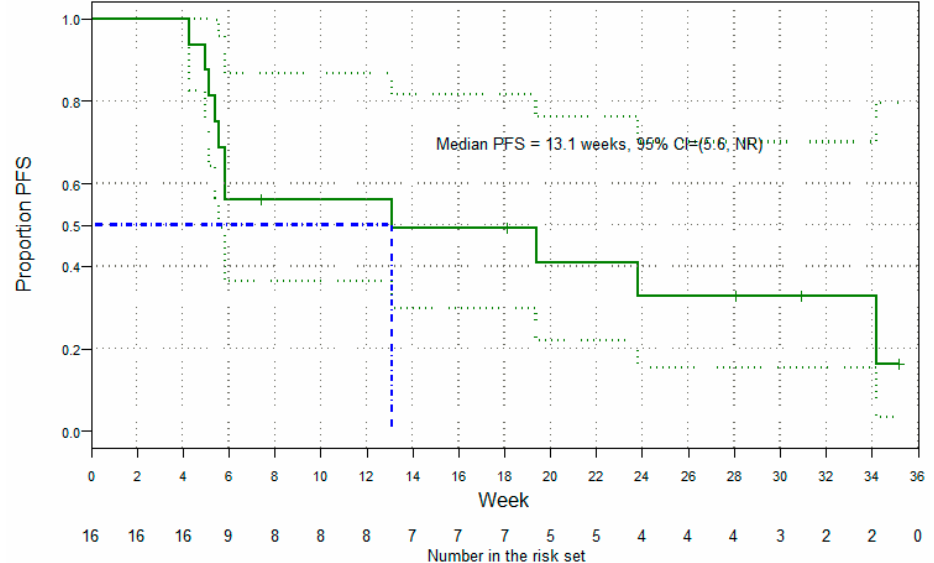
Figure 5. Secondary endpoint: Kaplan–Meier survival curve in the efficacy-evaluable population.